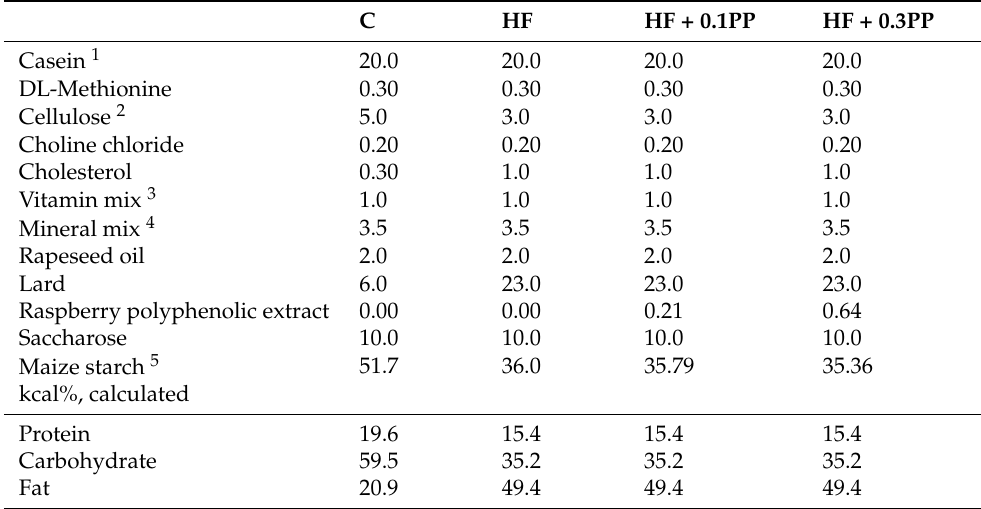
Table 2. Compositions of the diets used in the in vivo rat experiment, g/100